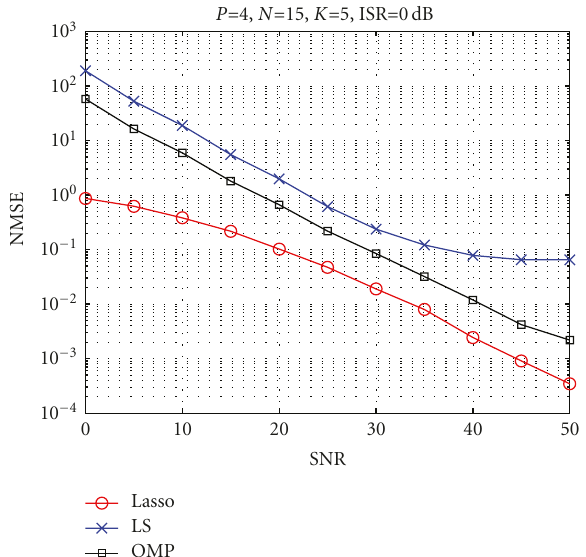
Figure 8: Probability of missed detection versus SNR (asyn- chronous system with multipath fading channel and unknown K ).